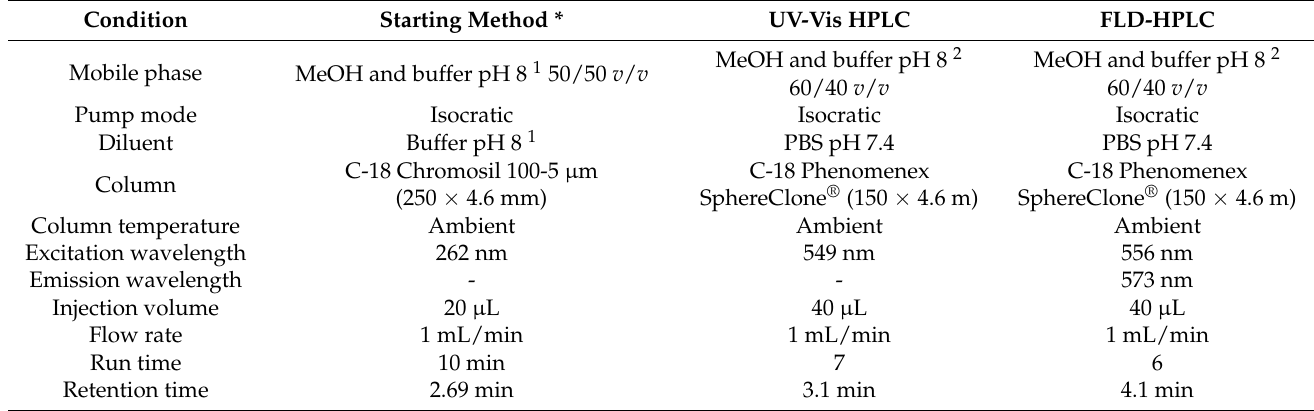
Table 1. Chromatographic conditions were used to develop the method for the quantification of RB in the